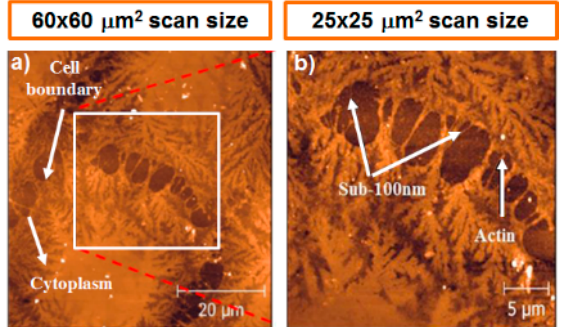
(FOV) = 80 × 80 μ m 2 and 25 × 25 μ m 2 ( a , b ). The images were acquired with exposure of 200 SXR pulses,